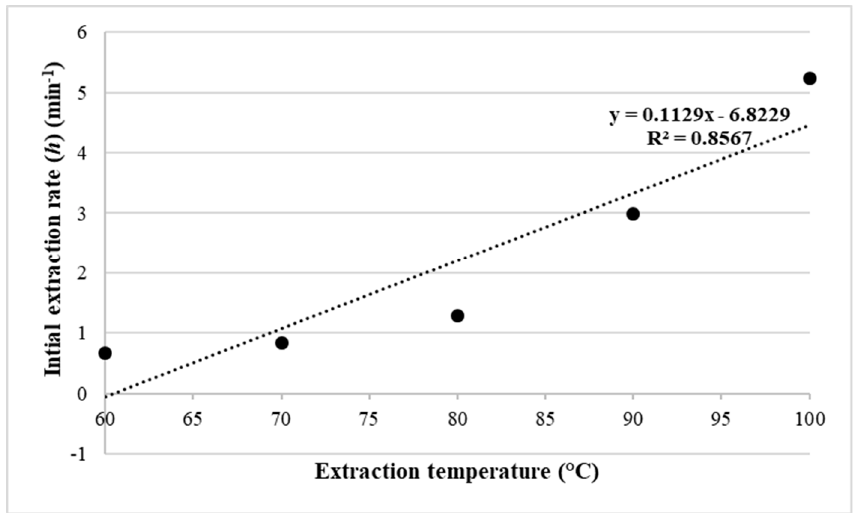
Figure 2. Effect of the extraction temperature on the initial extraction rate of Nannochloropsis sp. microalgae using MAE-brine according to the second-order Rate Law model.